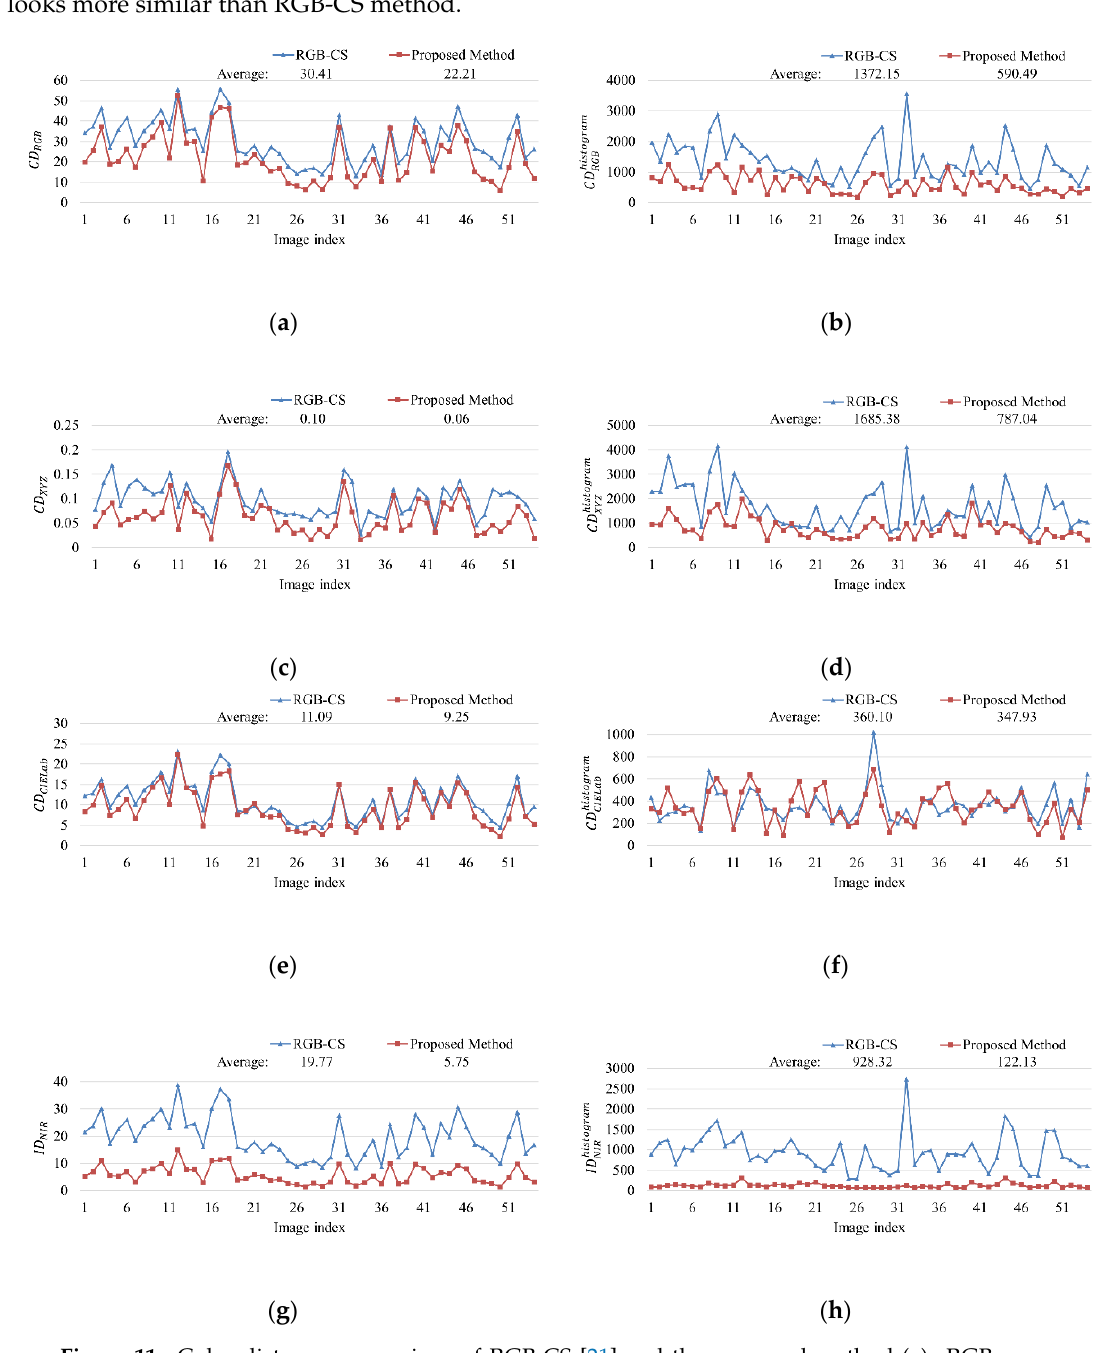
Figure 11. Color distance comparison of RGB-CS [21] and the proposed method ( a ) sRGB space, ( b ) Histogram in sRGB space, ( c ) XYZ space, ( d ) Histogram in XYZ space, ( e ) CIELab space, ( f ) Histogram in CIELab space, ( g ) intensity distance of NIR image, ( h ) Histogram distance of NIR intensity.